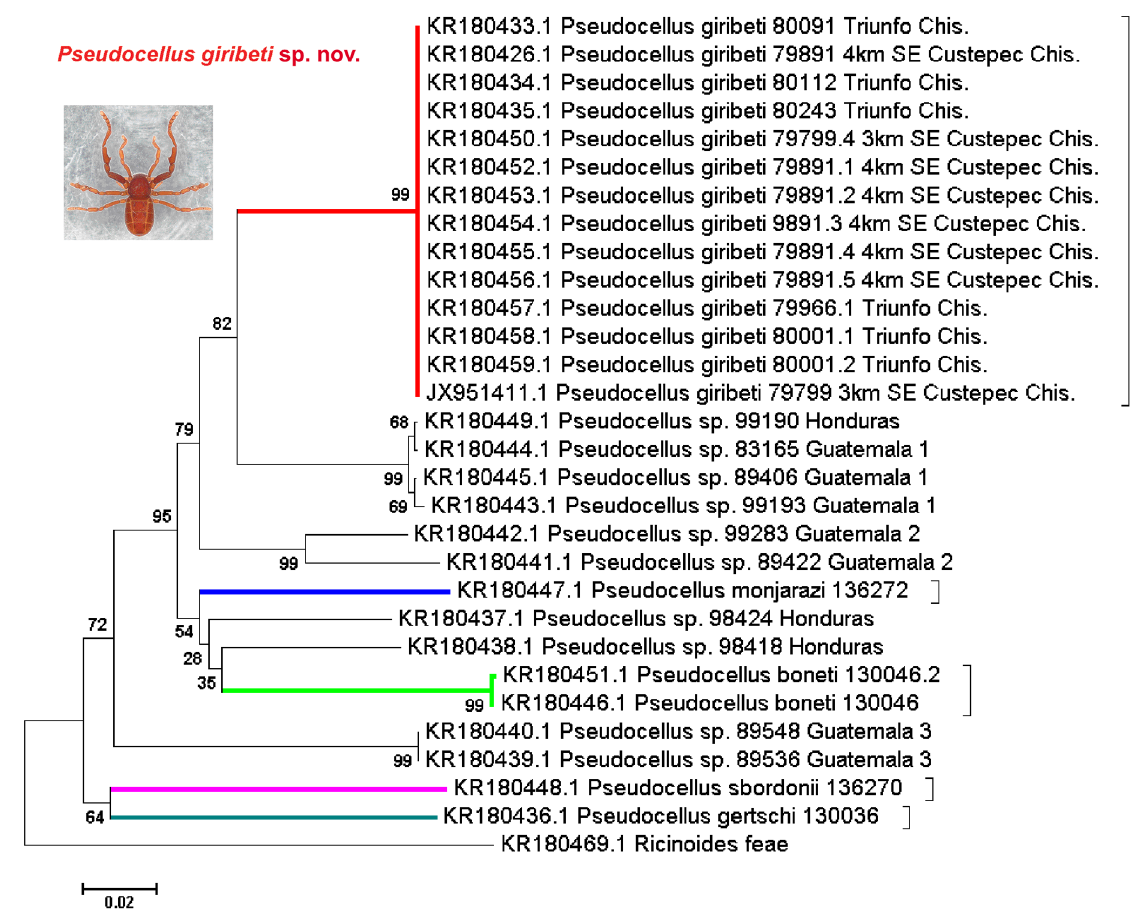
Fig. 1. Neighbour-Joining (NJ) tree with p- distances constructed with COI barcode sequences from different specimens and species of Pseudocellus Platnick, 1980 . Colors of the branches indicate species of Pseudocellus already described, red branches indicate the new species. Numbers on the branches represent Bootstrap support values (>50%